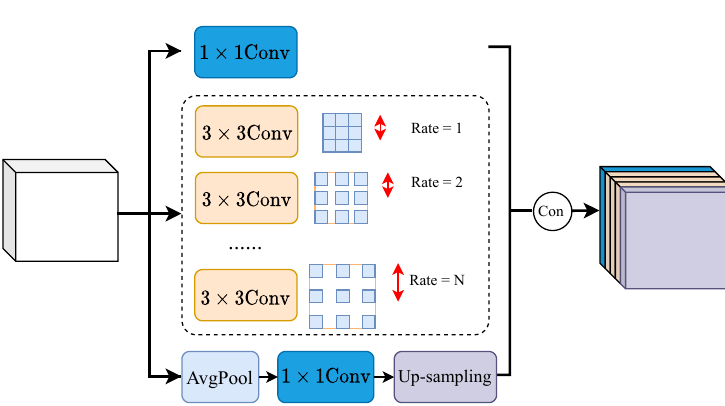
Figure 6. The details of the proposed Global–Local Context